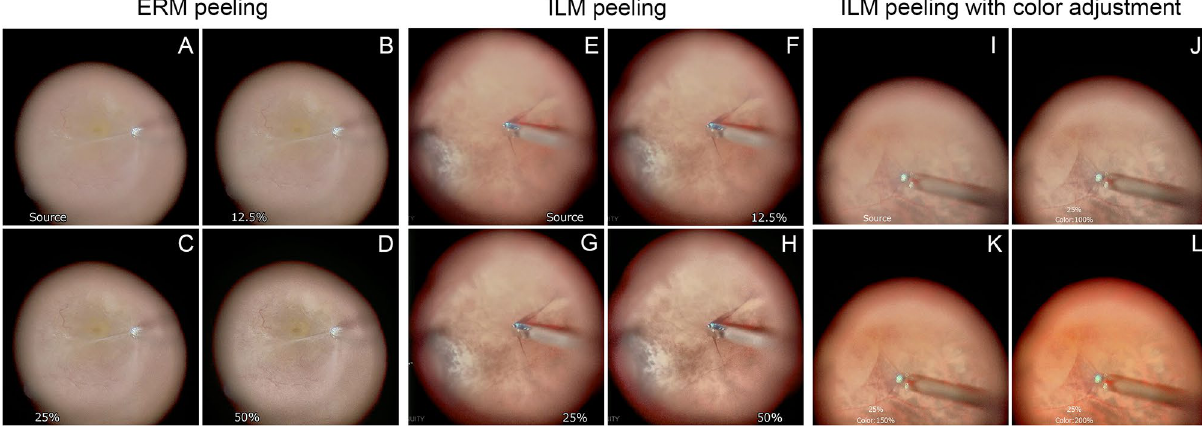
Figure 5. Images during the peeling of an epiretinal membrane (ERM) and an internal limiting membrane (ILM). Surgical images during ERM peeling seen through a flat contact lens with the original image ( A ), 12.5% ( B ), 25% ( C ), and 50% ( D ) intensity of image-sharpening show that the edge of ERM appears clearer with the image-sharpening and the patterns of retinal vessels and retinal folds also appear more clearly with the increase of the image-sharpening intensity. The images during ILM peeling with the aid of the yellow filter through a flat contact lens with the original image ( E ), and with 12.5% ( F ), 25% ( G ), and 50% ( H ) intensities of the image- sharpening showing that the edge of ILM stained blue with BBG appears clearer with the image-sharpening. Images of the surgical field during ILM peeling with color adjustments by a yellow filter with the original image ( I ), 12.5% of the image-sharpening intensity ( J ), 150% of color adjustment and 12.5% of the image-sharpening intensity ( K ), and 200% of color adjustment and 12.5% of the image-sharpening intensity ( L ) indicate that the peeled ILM appears clearer with the color adjustment. The yellow color is emphasized more than enhanced by the yellow filter, and the color tone is observed more clearly with the color adjustment. In particular, the BBG- stained ILM and unstained areas are more clearly